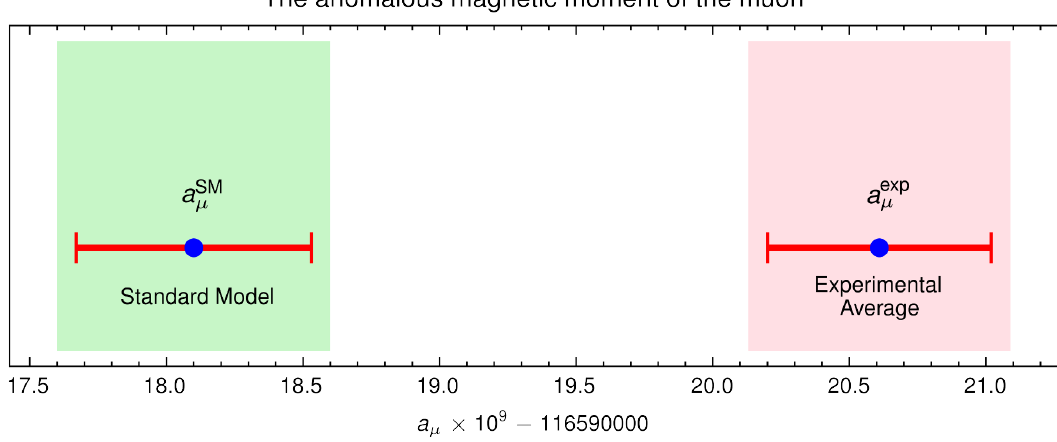
Figure 1 . The disparity between the theoretically expected anomalous magnetic moment and the experimental average with the corresponding error bars. The gap between these points corresponds to the aforementioned σ = 4 . 2